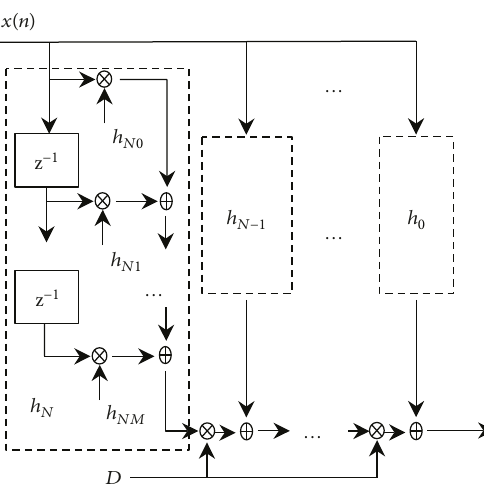
Figure 3: The structure of the Farrow fi